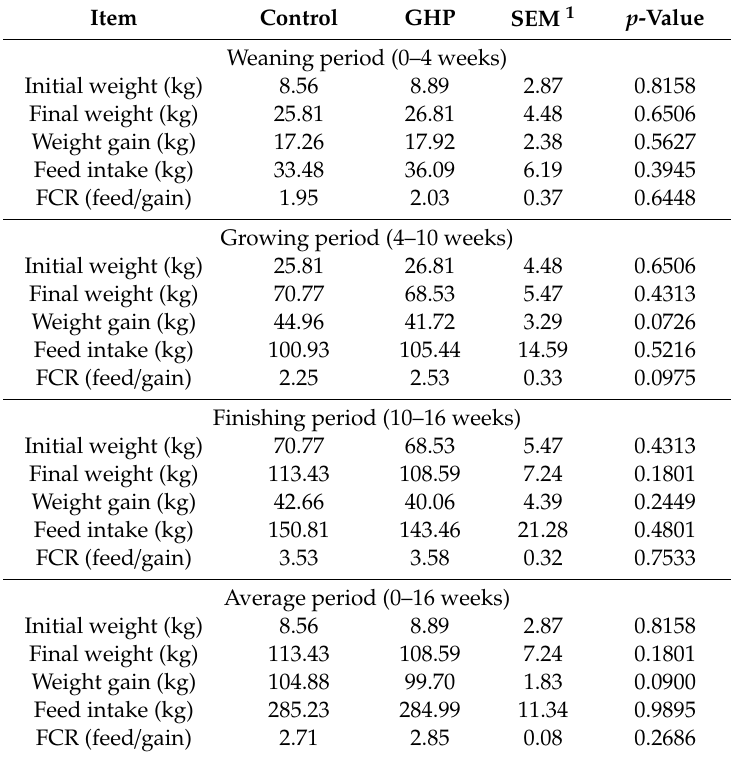
Table 6. E ff ect of the geothermal heat pump (GHP) on production performance parameters. Item Control